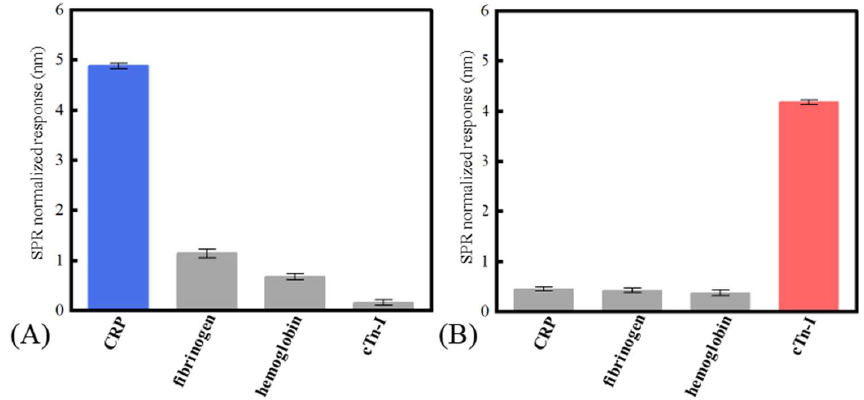
Figure 5. The selectivity of the biosensor: ( A ) the sensor modified with the CRP aptamer; ( B ) the sensor modified with the cTn-I aptamer.